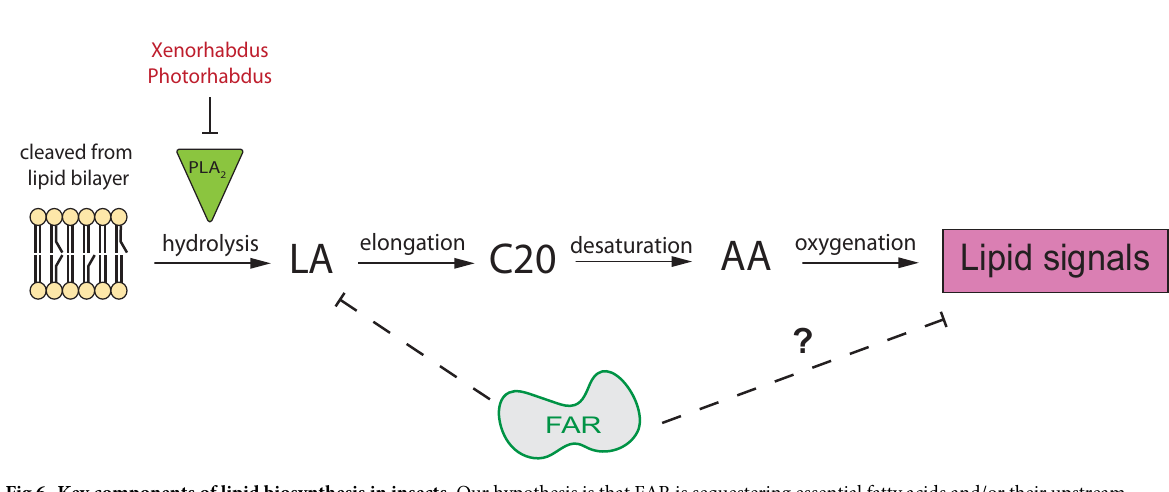
Fig 6. Key components of lipid biosynthesis in insects. Our hypothesis is that FAR is sequestering essential fatty acids and/or their upstream lipids to disrupt lipid signaling that is necessary for certain host immune functions. We have shown FARs’ ability to bind to L A in vit ro which could temporarily disrupt downstream eicosanoid signaling. In insects, phospholipase A2 cleaves linoleic acid (LA) from the lipid bilayer instead of arachidonic acid in mammals. Free LA is then extended via an elongase to a C20 fatty acid. Desaturase oxidizes the C20 to arachidonic acid which can then be oxygenated to yield eicosanoid-like molecules. Eicosanoids are involved in many important functions including gene expression, immune regulation and reproduction. Adapted [36].